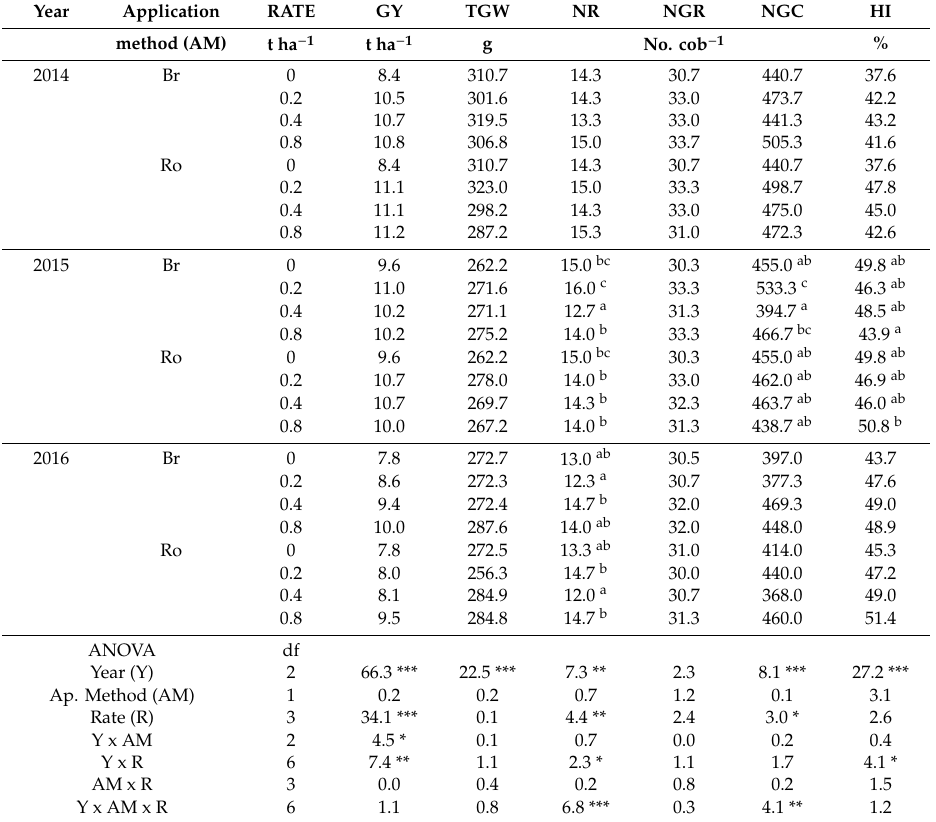
Table 3. E ff ect of digestate application method and rate on grain yield and maize yield components in consecutive years of